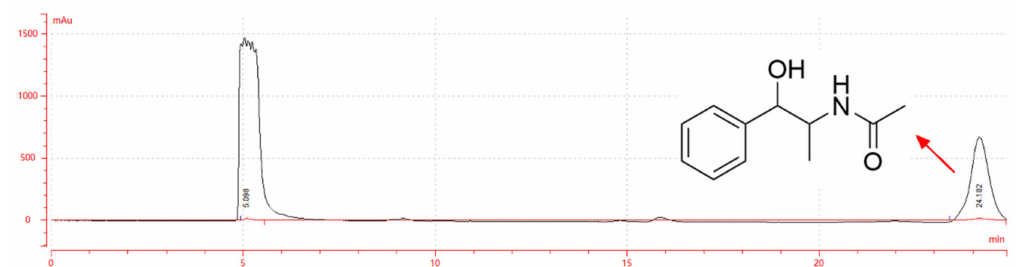
Figure 1. Liquid chromatogram and structural formula of